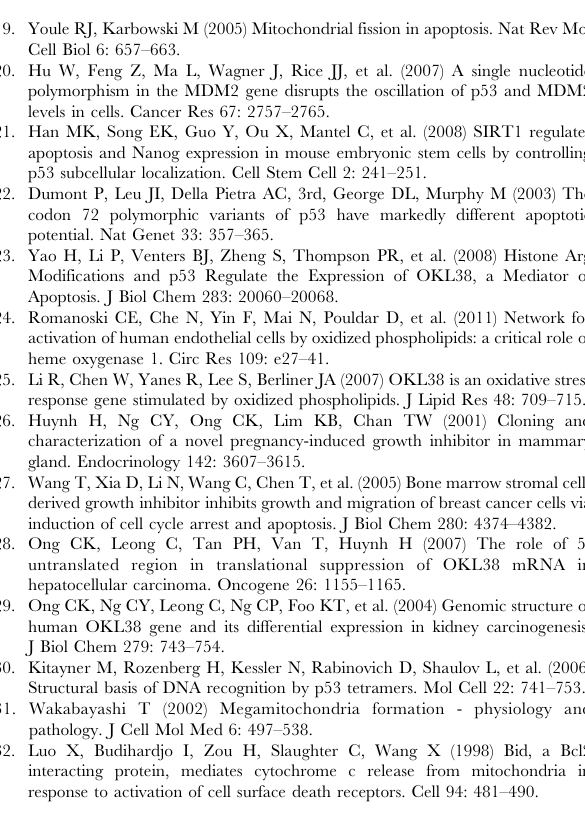
Figure S3 FLAG-OKL38 staining overlaps with mito- chondrial protein COX I. (A) Large cytoplasmic speckles enriched with FLAG-OKL38 were stained by anti-OKL38 rabbit pAb (green colored). These large speckles are also positively labeled with the COX I mouse mAb antibody (red colored). The overlap between FLAG-OKL38 and COX I staining indicate that these large speckles are formed by mitochondria. (B) COX I staining overlaps with that of the MitoTracker staining in the large speckles formed after FLAG-OKL38 transfection. (C) Large cytoplasmic speckles induced by FLAG-OKL38 241–477 were stained by anti-OKL38 rabbit pAb (green colored) as well as the COX I mouse mAb antibody (red colored). (TIF) Figure S4 Subcellular distribution of FLAG-OKL38 truncations in U2OS cells. (A) OKL38 residues 1–240. (B) OKL38 residues 1–300. (C) OKL38 residues 241–477. (D) OKL38 residues 301–477. (E) Over 250 cells from independent experiments were scored by two observers for subcellular localization of OKL38 and its truncation derivatives. Percentages of cells with mainly mitochondrial, mainly nuclear, or both mitochondrial and nuclear OKL38 localization are shown in the bar graphs. Figure S5 Effects of FLAG-OKL38 on the GFP-mito reporter distribution. (A–B) FLAG-OKL38 full length construct was co-transfected with the GFP-mito reporter construct in U2OS cells. Fragmentation of mitochondria and formation of large mitochondria speckles were detected in live cell imaging analyses.